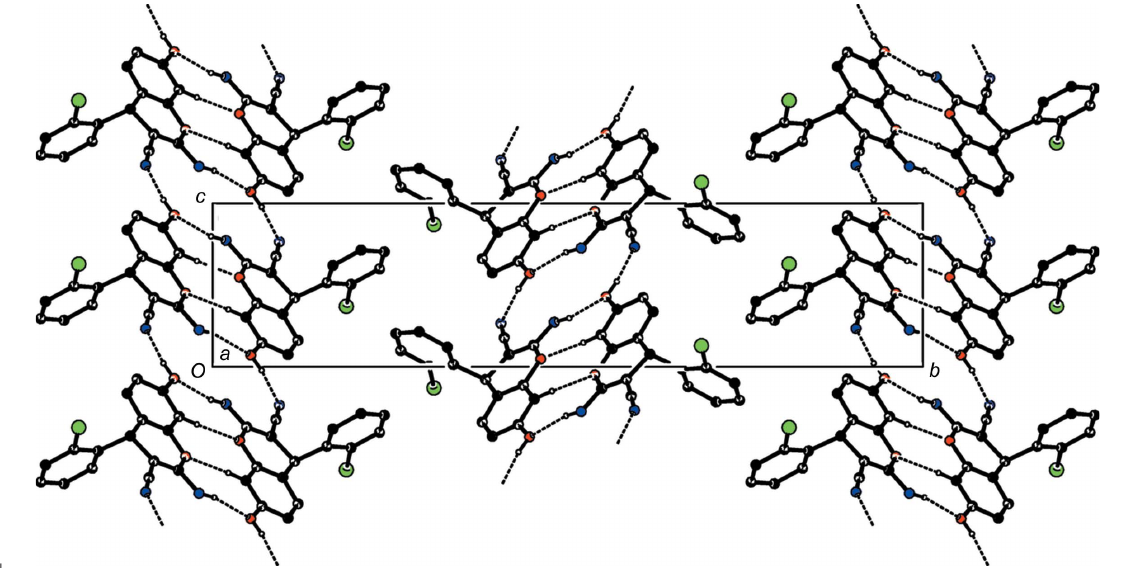
Figure 4 The overall crystal packing of the title compound, viewed along the a -axis